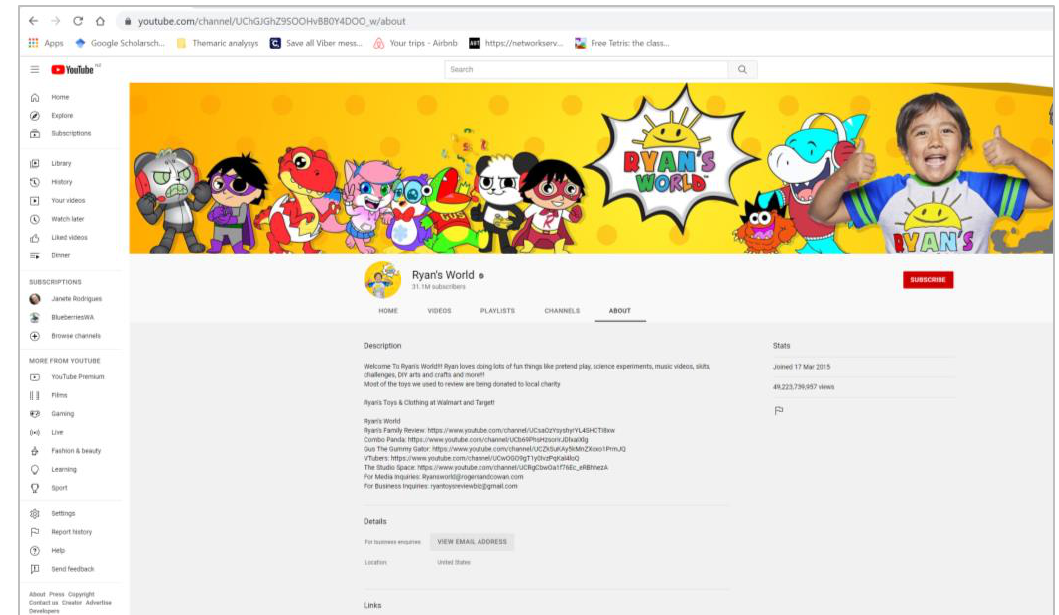
Figure 2. A vlogger’s site (Available online: